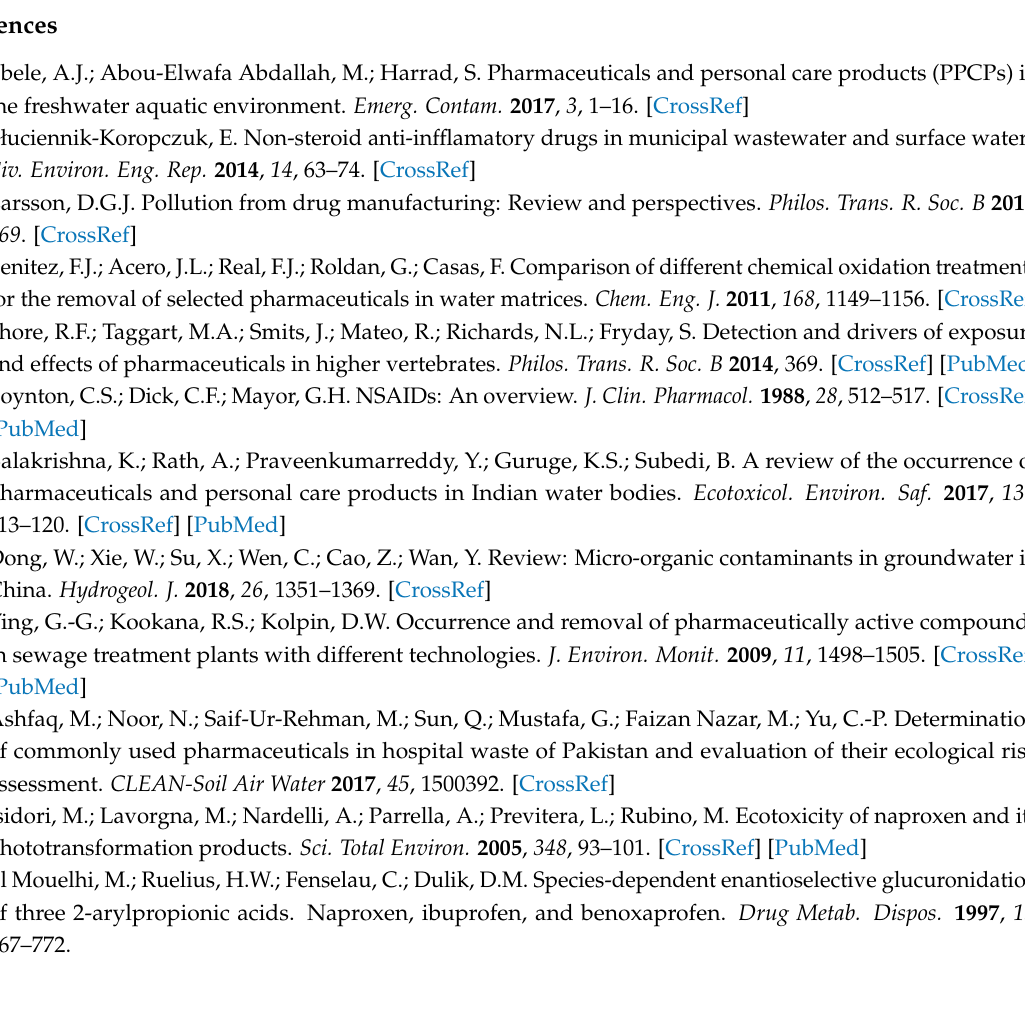
reaction; Figure S5: Chromatogram of NAP standard; Figure S6: Evolution of the aromaticity content (a) for the three tested real-aqueous matrices spiked with NAP; (b) for SW sample and SW sample spiked with NAP; Table S1: Comparison of iron-based catalytic systems for the removal of NAP in liquid phase; Table S2: NAP degradation products detected by (-)-ESI-LC-MS analysis; Table S3: Representative analysis of the three real aqueous